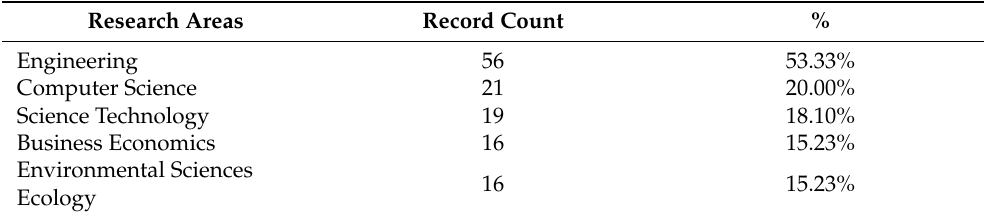
Table 5. The main areas of science to which the analyzed articles were classified; Source: own